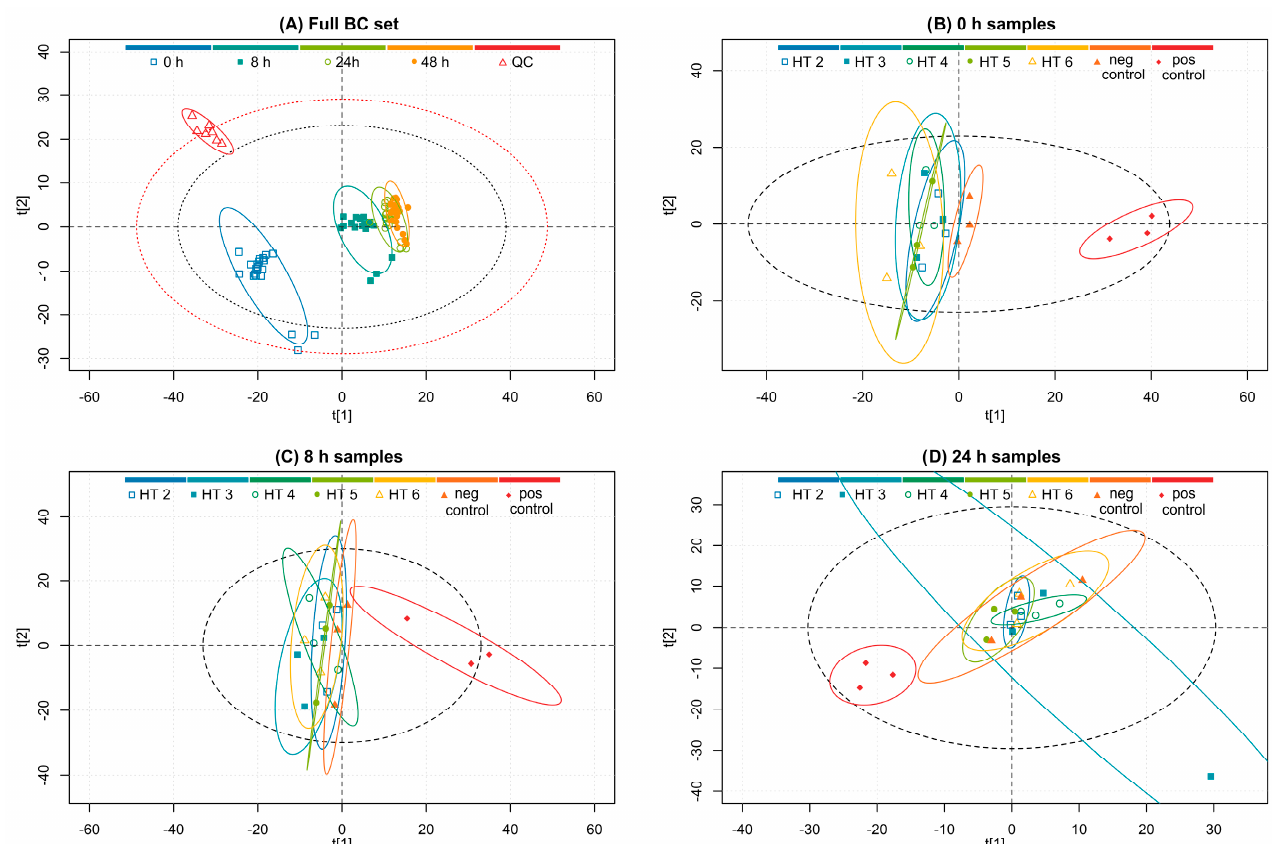
Figure 8. PCA model score plots of the ( A ) full fecal BC sample set (R 2 X(1) = 0.38, R 2 Y(2) = 0.13), ( B ) samples at the 0 h time point (R 2 X(1) = 0.40, R 2 Y(2) = 0.11), ( C ) samples at the 8 h time point (R 2 X(1) = 0.23, R 2 Y(2) = 0.19), and ( D ) samples at the 24 h time point (R 2 X(1) = 0.19, R 2 Y(2) = 0.18). Plot ( A ) groups according to the time point or quality control (QC), and plots ( B – D ) groups according to the HT treatment or control. Red and grey ellipses show Hotelling’s T 2 99% and 95% confidence intervals, respectively, and group ellipses show 95% confidence intervals. ( A ) 0 h samples ( □ , dark blue), 8 h samples ( ■ , dark green), 24 h samples ( ⚪ , light green), 48 h samples ( ⚫ , orange), and quality control samples ( △ , red). ( B – D ) HT 2, castalagin ( □ , dark blue); HT 3, tellimagrandin II ( ■ , turquoise); HT 4, pentagalloylglucose ( ⚪ , dark green); HT 5, salicarinin A ( ⚫ , light green); HT 6, rugosin D ( △ , yellow); negative control ( ▲ , orange); and positive control ( ♦ , red).